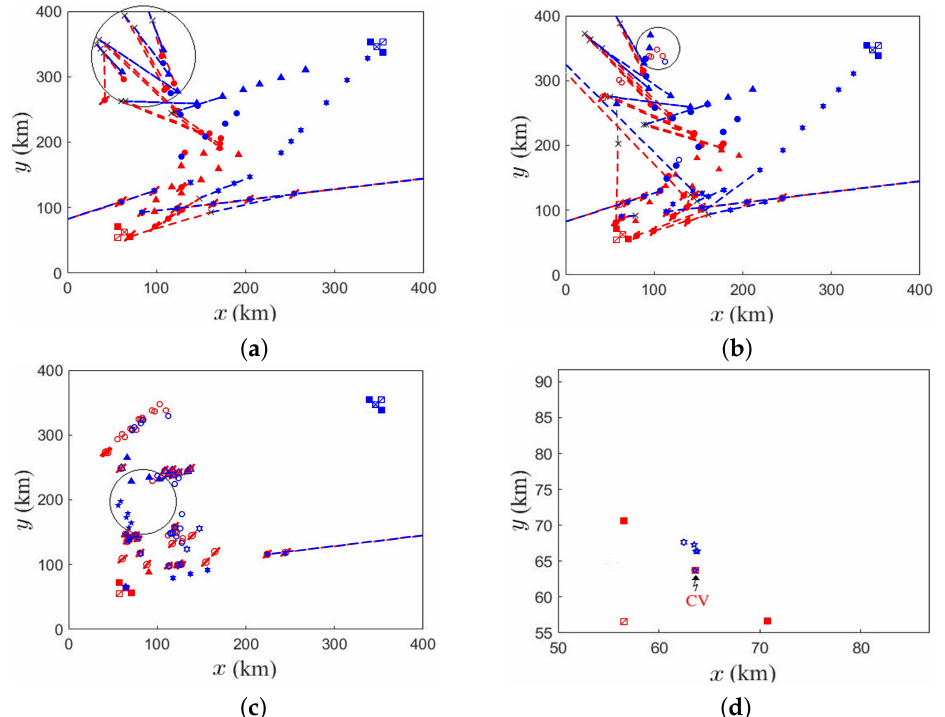
Figure 23. Specific game on A1/B2, fighters from fleet B attacking CV-A, ( a ) t = 1020 s, ( b ) t = 1200 s, ( c ) t = 1890 s, ( d ) t = 2145 s. Symbols are referred to Table